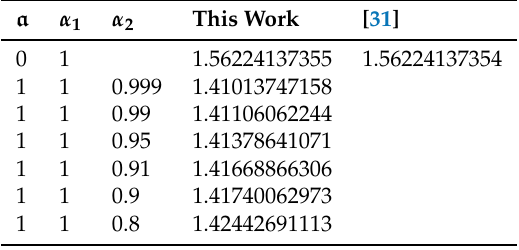
Table 7. J ∗ for Example 4.